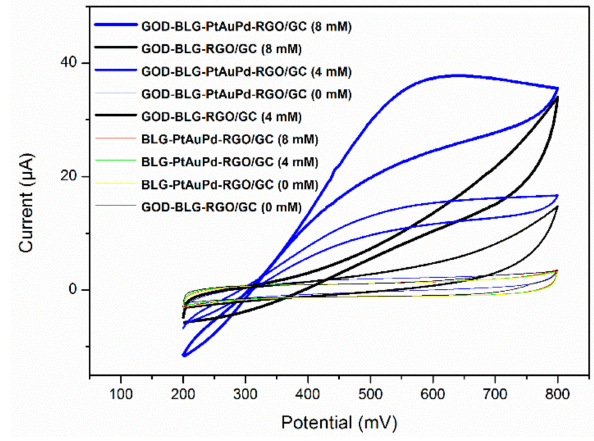
Figure 3. CVs response of GOD-BLG-PtAuPd-RGO/GC, GOD-BLG-RGO/GC and BLG-PtAuPd- RGO/GC electrodes upon different concentration additions with 0 mM, 4 mM and 8 mM glucose into pH 7.0, 0.1 M phosphate buffered solution (PBS) under